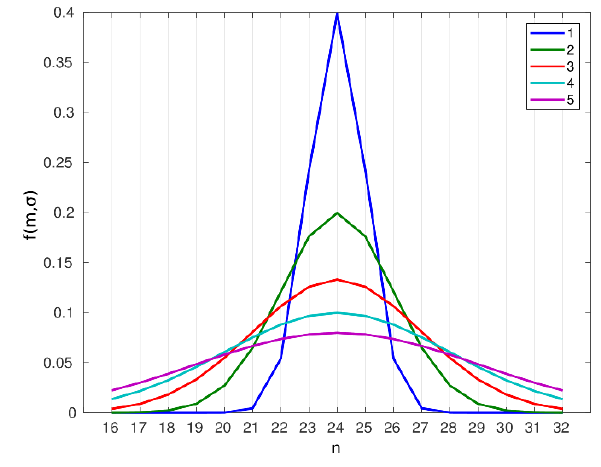
Figure 2. An example of nucleation-mode UFP compositions, rep- resented as mass fractions for surrogate compounds C n H ( 2 n + 2 ) , n = [ 16 : 32 ] , and described by a Gaussian distribution centred on C 24 H 50 with a standard deviation, σ , from 1 to 5.